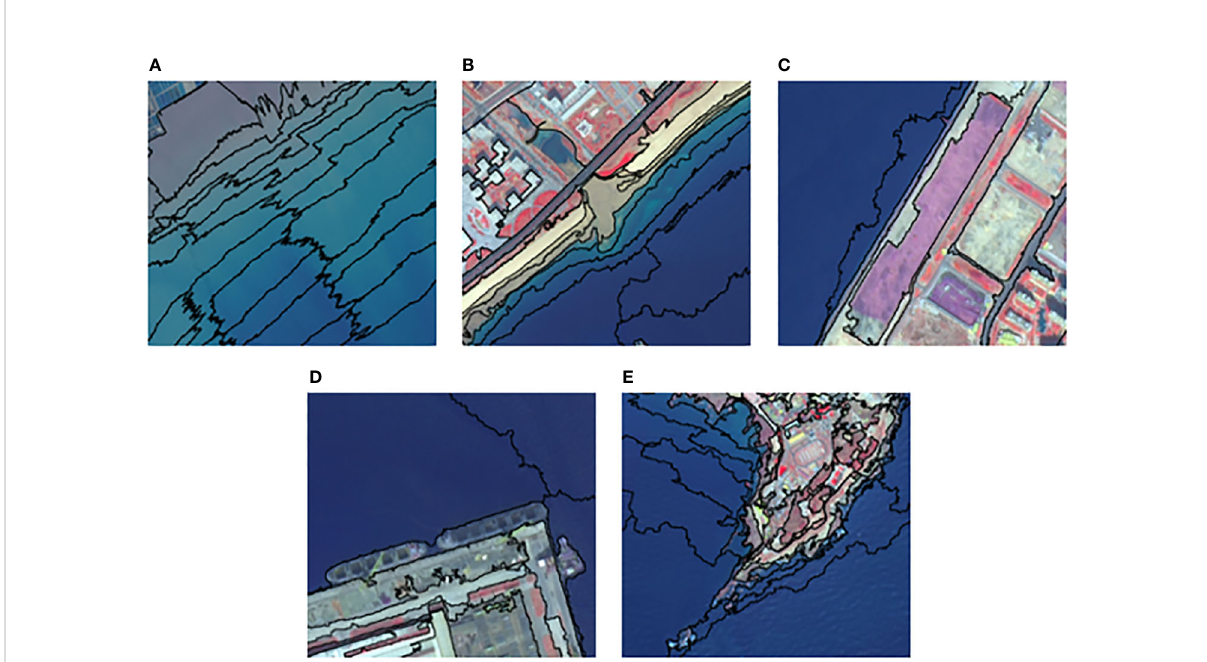
FIGURE 5 Different types of segmentation effects: (A) ocean, (B) sand, (C) harbor-wharf, (D) ship, and (E) rock.